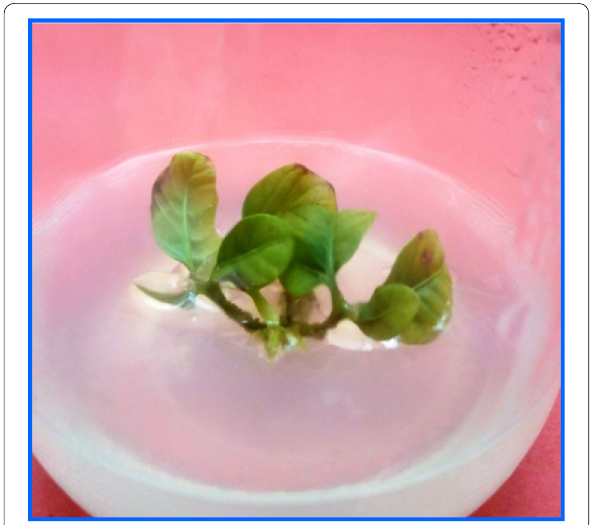
Fig. 1 Establishment of in vitro shoot tips micropropagation of Dimocarpus